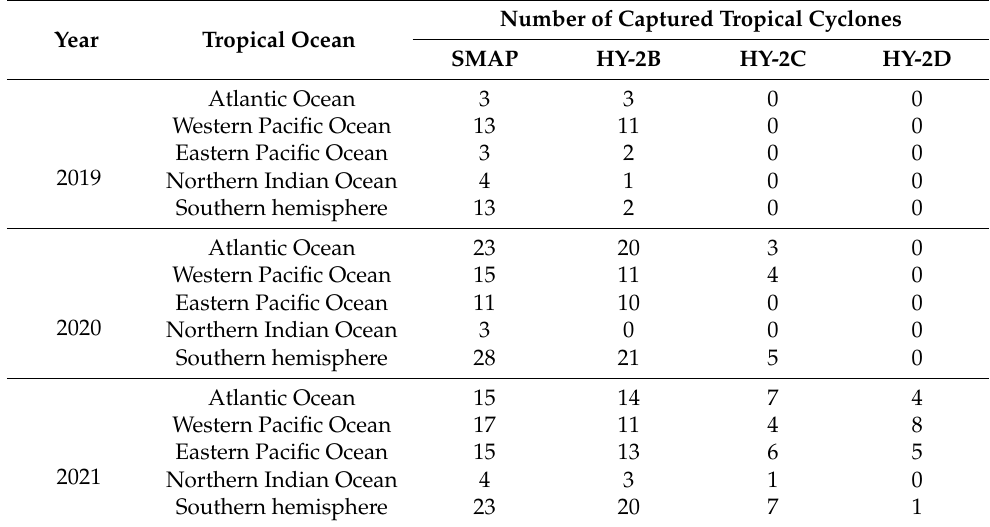
Table 3. Summary of tropical cyclones captured by SMAP during the period